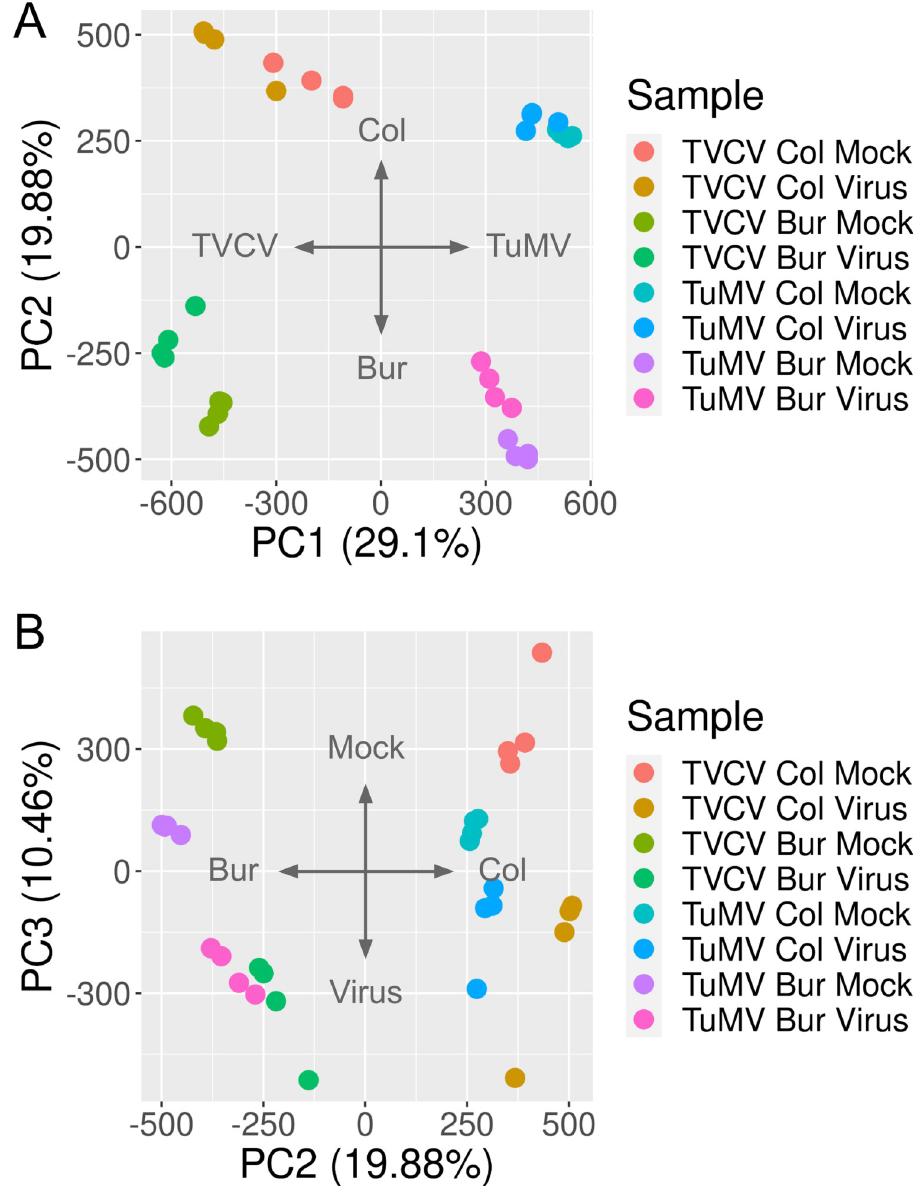
Fig 6. Principal component analysis of the sRNA-seq data. PCA was performed using the prcomp R package. DESeq2-normalized sRNA expressions were scaled and centered before the analysis. (A) The first component (PC1) separates the samples by virus series and explains 29.1% of the total variances between the samples while the second component (PC2) separates the samples by ecotype and explains further 19.88% of the variances. (B) The third component (PC3) separates samples that are either mock or virus-infected, which is responsible for a further 10.46% of the variances. The four biological replicates are marked with the same color for easier